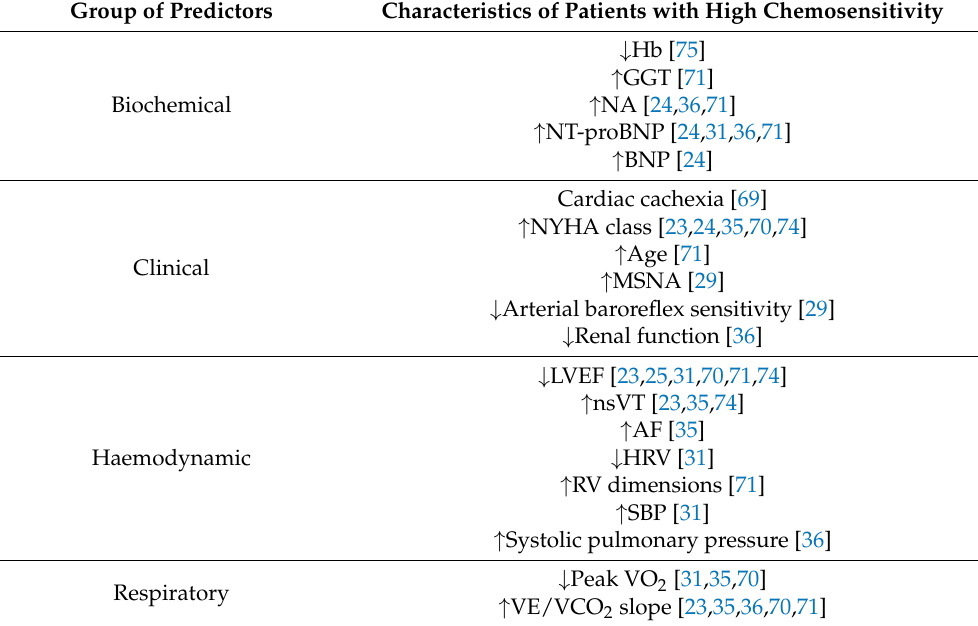
Table 4. Predictors of increased chemosensitivity extracted from clinical trials. Group of